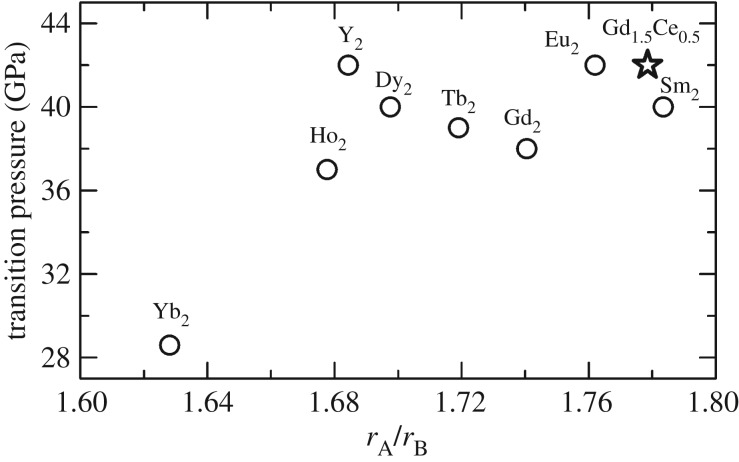
Correlation plot between the transition pressure to a cotunnite-like structure for titanite pyrochlores and the cationic radii ratio (rA/rB). The ionic radii of the A-site REE are the value of the eightfold coordinated cations with the chemical valence of +3, and Ti4+ ionic radius is the value of the sixfold coordinated cations. The round black marks represent the transition pressure listed from previous research (table 1) and the star represents the results of this study.